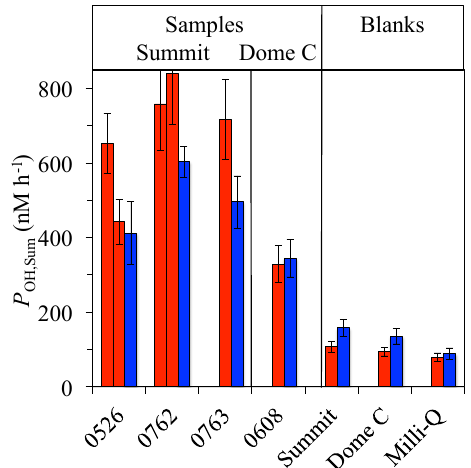
Figure 3. Rate of • OH formation in Summit and Dome C snow samples studied as solution (274K, red) and as ice (263K, blue), after normalization to Summit summer solstice sunlight. Error bars represent ± 1 standard error, based on propagated errors in the rate of p -HBA formation ( P p -HBA ) and Y p -HBA . Sample values are not adjusted for • OH formation in the blanks.